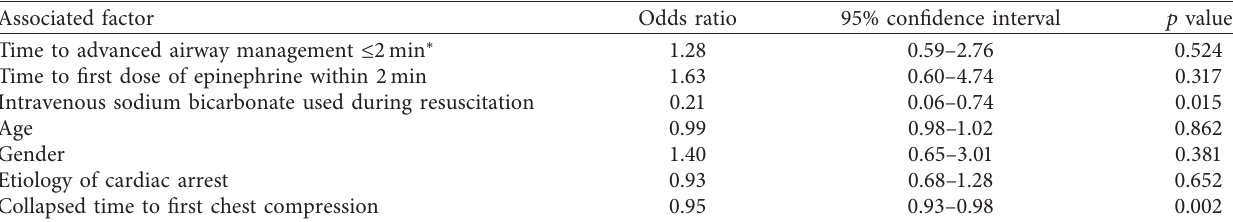
Table 3: Odds ratio from multivariate logistic regression predicting survival to hospital discharge from time to advance airway management ≤ 2 minutes VS > 2